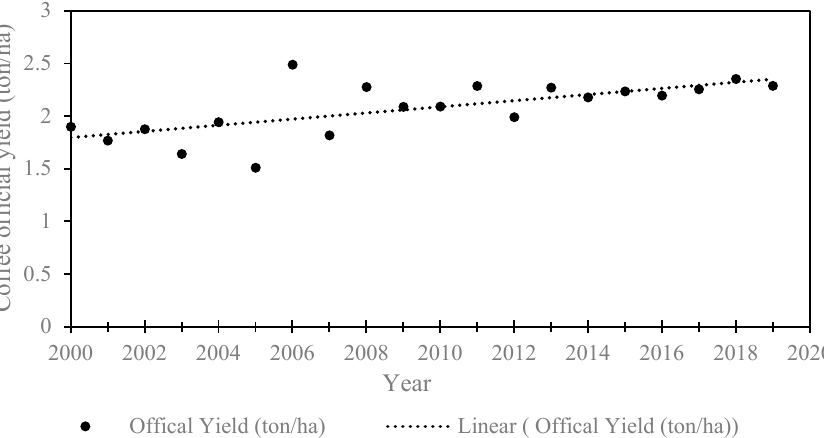
Figure 3. Time trend for official coffee yield of Dak Lak province for the period from 2000 to 2019. Details of the eight best coffee yield models for Dak Lak province obtained with the multivariate regression method of the CST for the two periods considered (mid-February to end of May and early January to end of June) are presented in Table 3 and Figure 4. 7.5% and 8.6%, and the Adjusted-R 2 varying between 62.8% and 68.8% (Table 3 Table 3. Details of the eight best coffee yield models for Dak Lak province based on phenological variables derived from NDVI, FAPAR, and LAI for the 2000–2019 time period, with their related statistical perfomrances. Models 1 to 4 are based on dekads 1 to 18 (January to June), and models 5 to 8 are based on dekads 5 to 15 (mid ‐ March to end of May). Model 0 corresponds to the model achieved with the coffee yield linear time trend only.